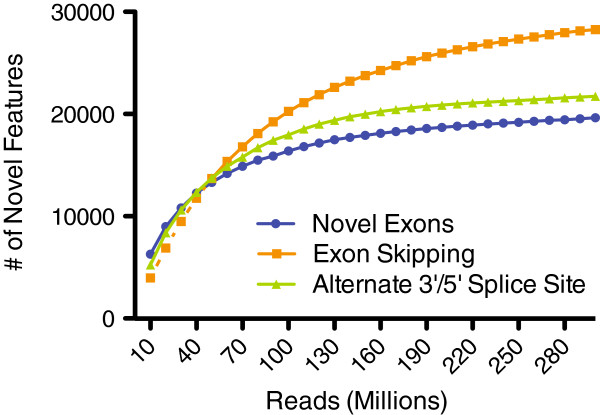
Depth of coverage plots for the detection of novel splicing events in the human retinal transcriptome. The percent of annotated features detected for 10 million read increments are shown. For novel exons and alternate 3′ or 5′ splice sites, the coverage plots nearly plateau at 300 million reads, suggesting that 300 million sequence reads provides good depth of sampling for these features. The slope of the exon skipping curve suggests that a majority of the exon skipping events have been detected, but that additional events could be detected with greater depth of sequencing.